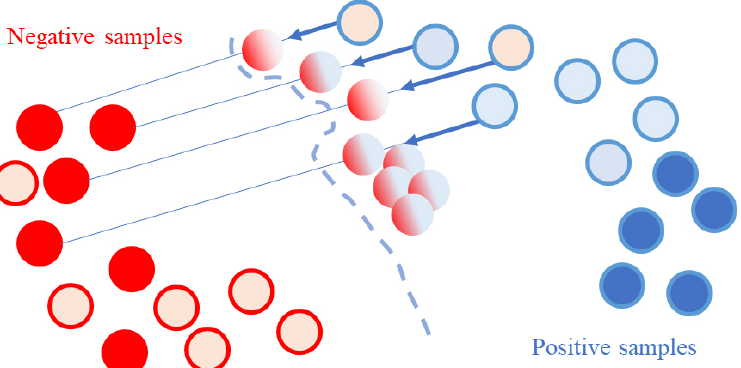
Figure 3. The data manifold under the environment to use weakly labeled data. The blue points are labeled as entities and the red points are labeled as non-entities. The light-colored points are weak entities or non-entities assigned by the domain-specific knowledge base.